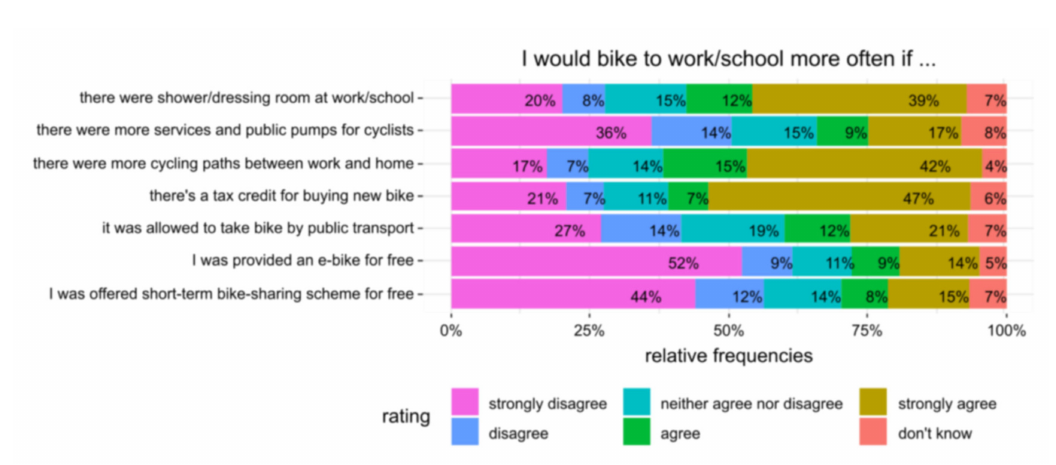
Figure 5. Perceived enablers of more frequent commuter